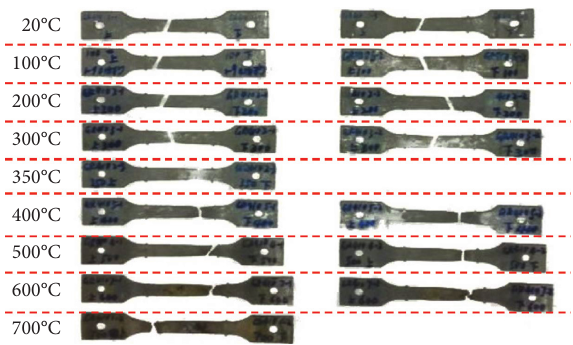
Figure 9: Failure modes for S420